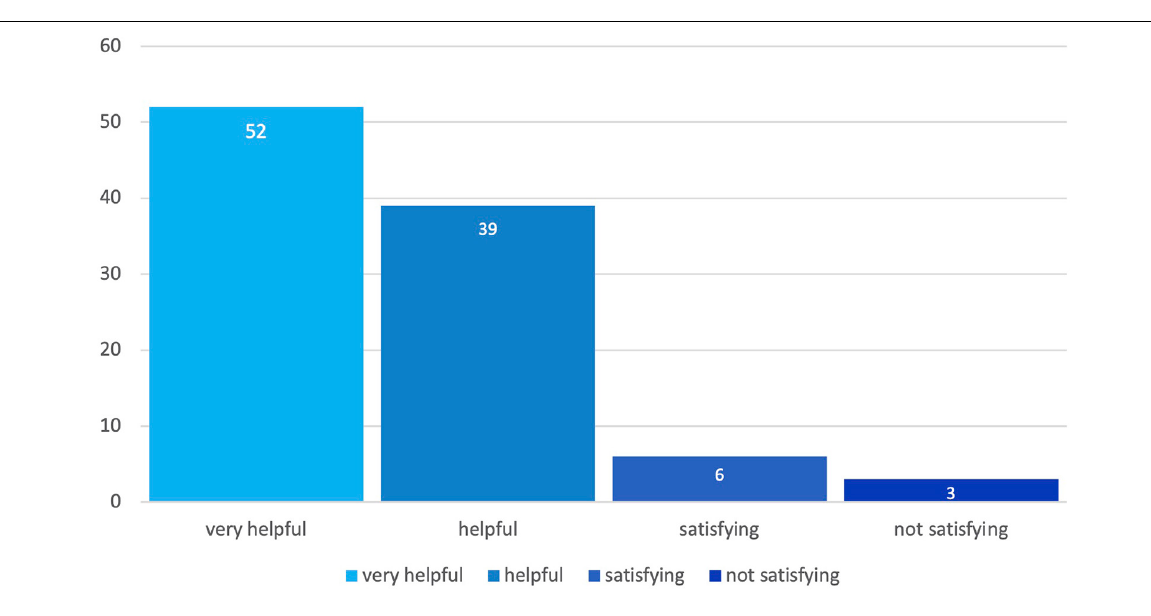
FIGURE 8 | Perceived benefit of the